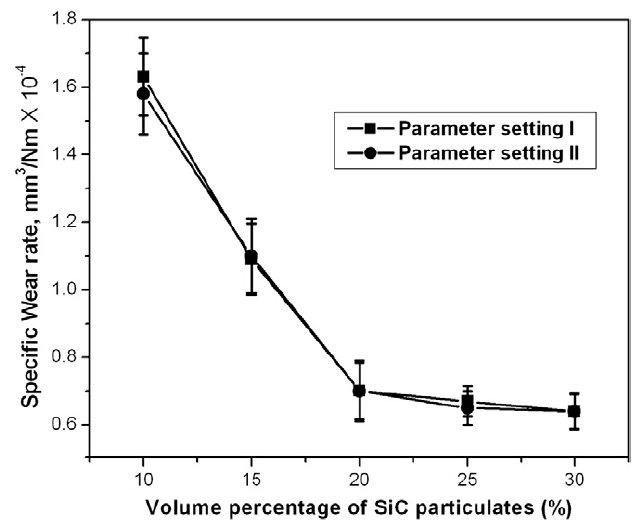
Figure 13. Graphical representation of specific wear rate vs. vol.% of SiCp variation. Reproduced from [57], with permission from Elsevier, 2011.